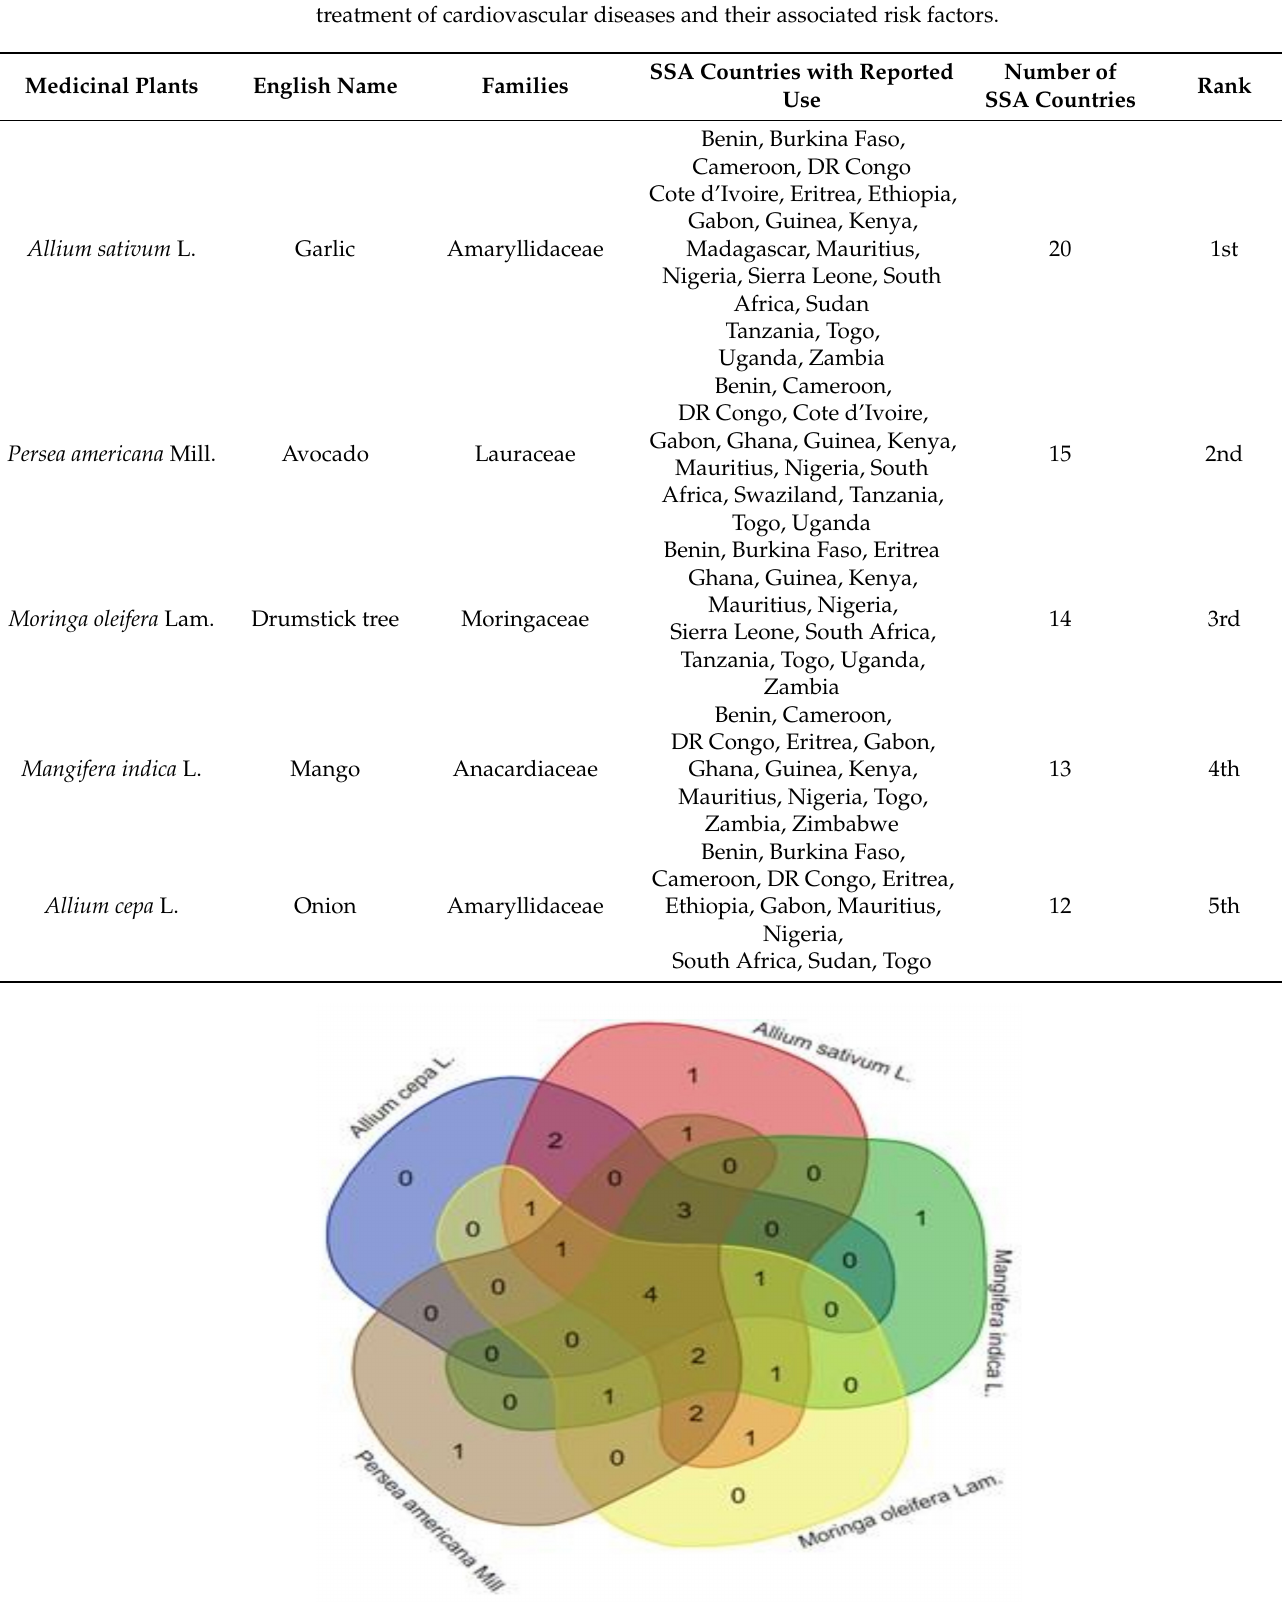
Figure 2. Venn diagram comparing the frequency of use of the five most utilised medicinal plants for cardiovascular diseases treatment in sub-Saharan African